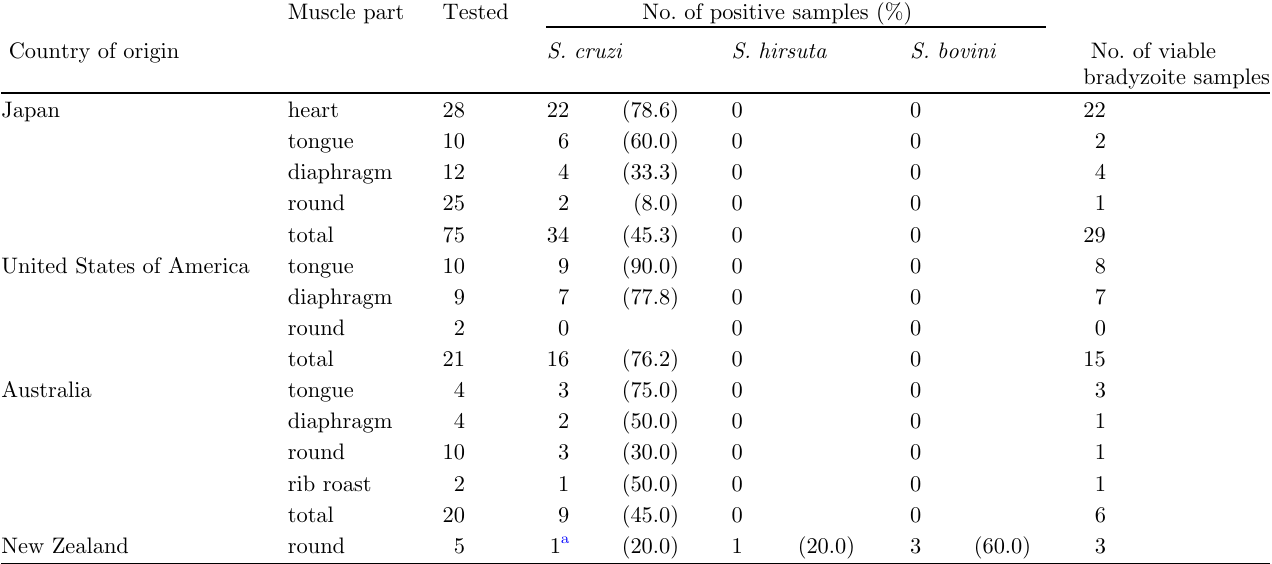
Table 2. Detection of Sarcocystis spp. from refrigerated beef. Muscle part